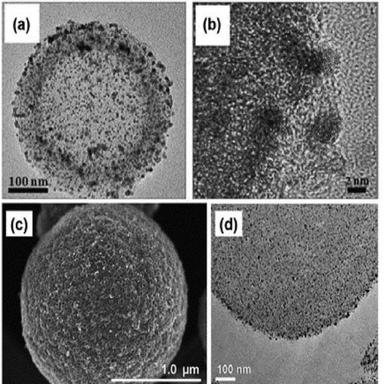
(a) TEM and (b) HR-TEM images of Pt (60 wt%)/HCSM300/50 catalyst (J. H.) (c) SEM image of Pt/templated carbon particles after pyrolysis and silica removal and (d) TEM image of Pt/templated carbon particle. Reprinted (adapted) with permission from (J. Phys. Chem. C 2010; 114; 4200–4207). Copyright © 2010 American Chemical Society (& Atanassov, 2010).